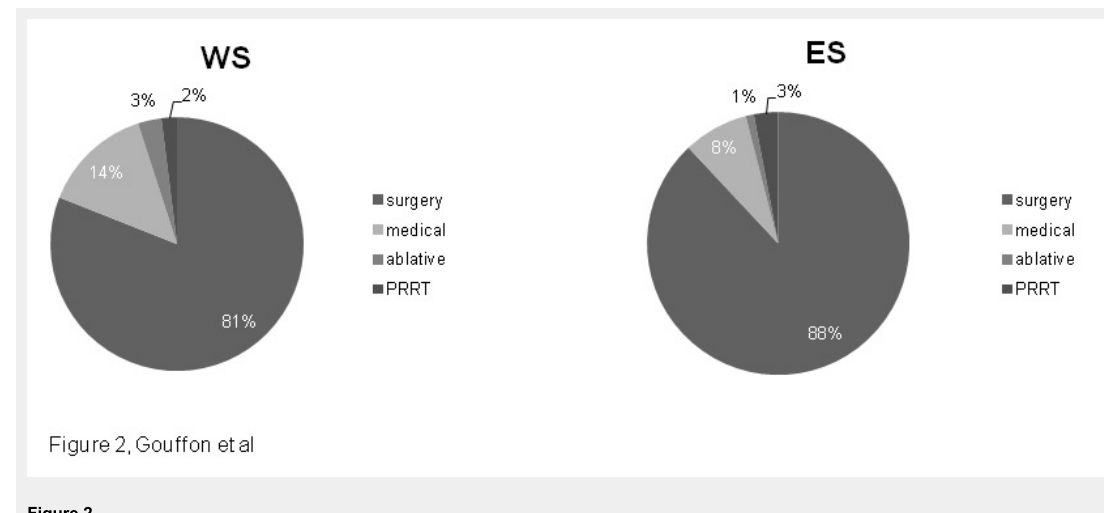
Figure 2 First line therapy in WS and ES. WS = Western Switzerland; ES = Eastern